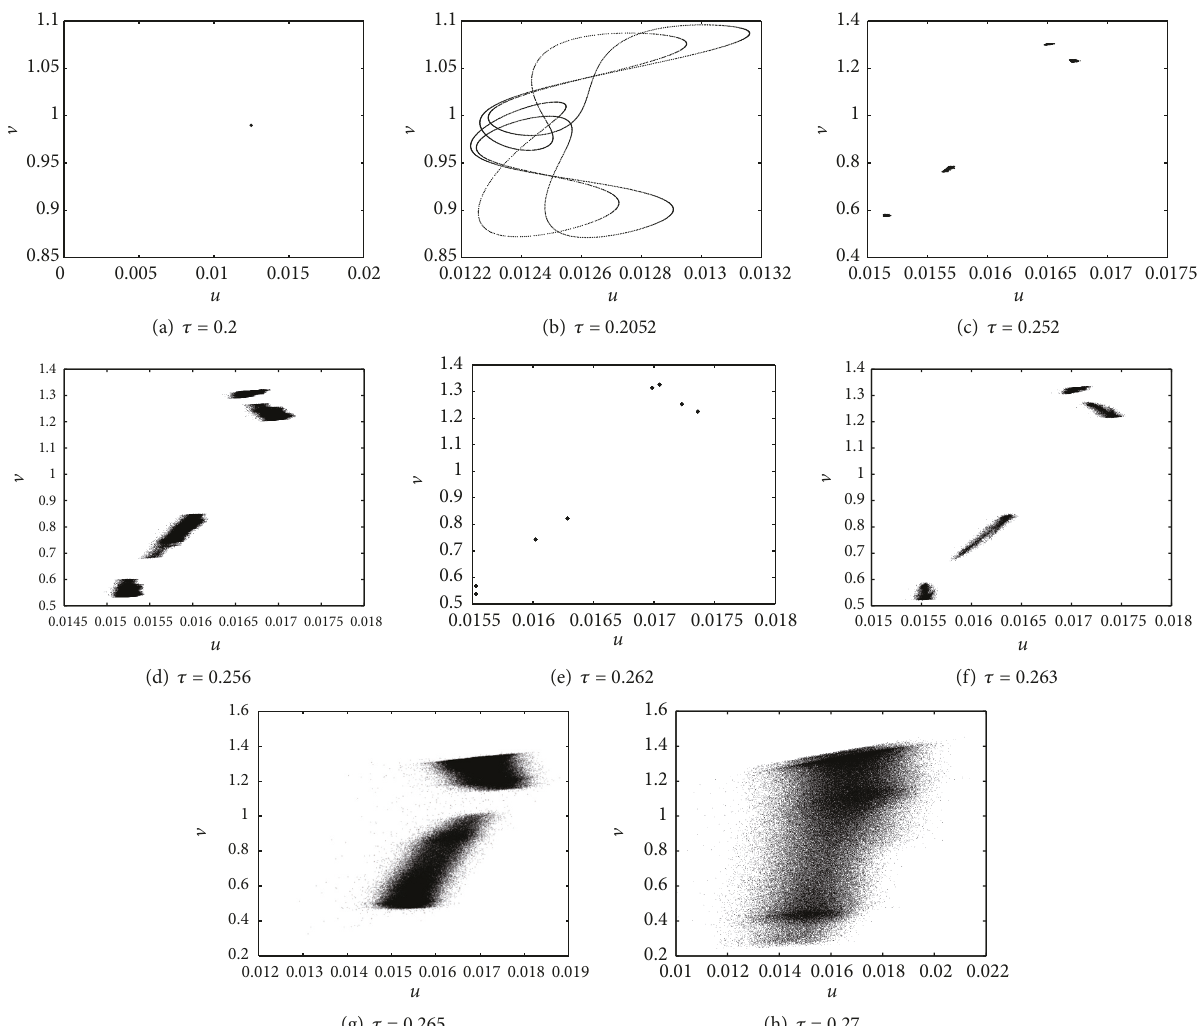
Figure 8: Phase diagrams for different values of parameter 𝜏 corresponding to Figure 7(b), demonstrating the predator-prey dynamics at one node of the coupled